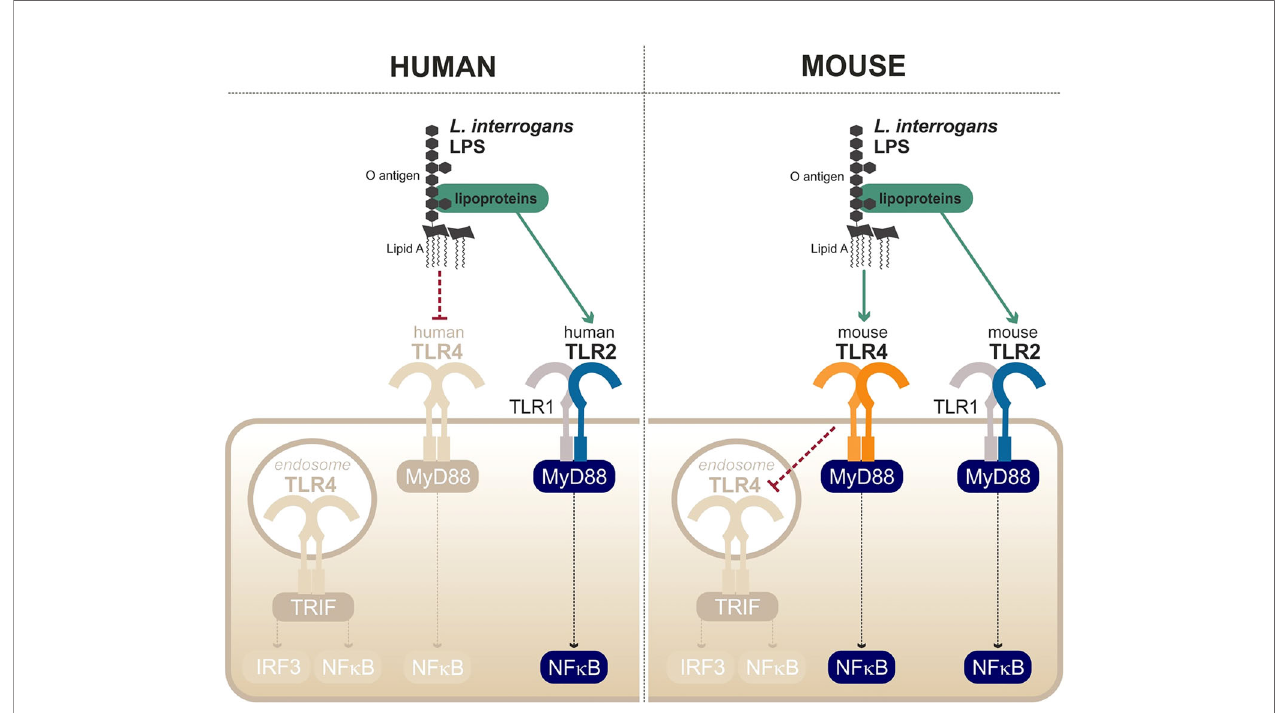
FIGURE 6 | Escape and partial recognition of the leptospiral LPS by human and mouse TLR4. Adapted from Werts et al. (2001), Nahori et al. (2005), Bonhomme et al.